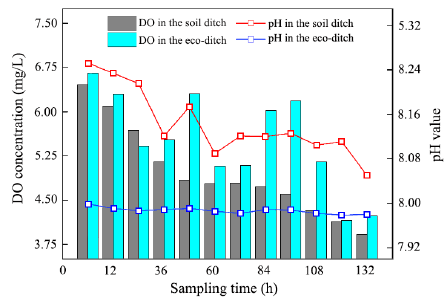
Figure 8. Changes of pH and dissolved oxygen (DO) in the eco-ditch and the soil ditch over time. Table 3. Effect of days on DO and pH of overlying water in the two ditches.